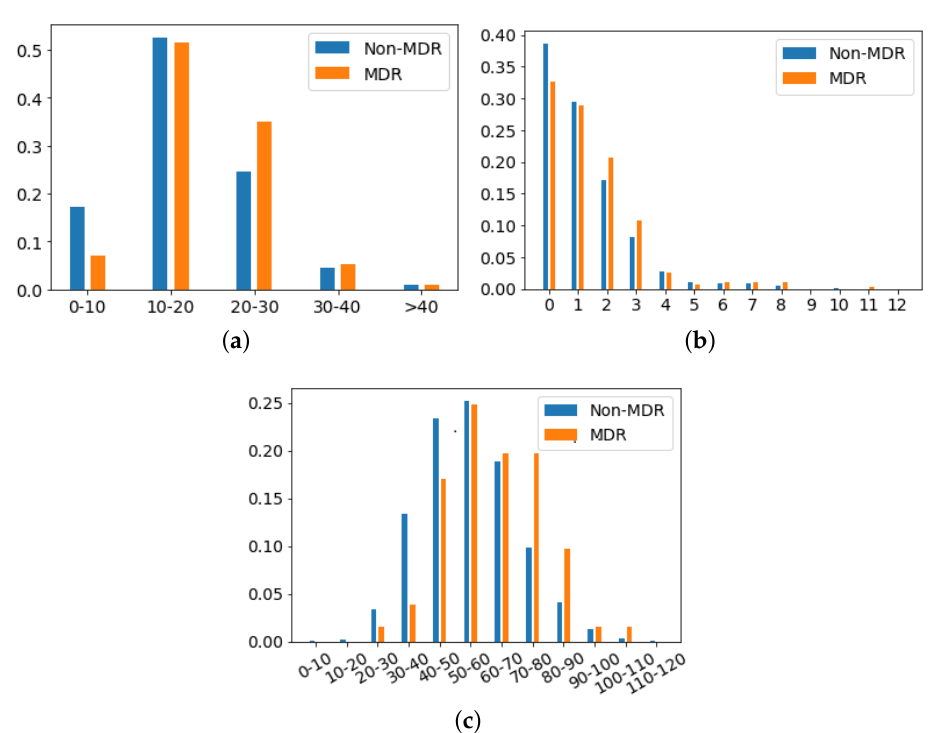
Figure 6. Rate of patient episodes for both MDR and non-MDR when three clinical scores are considered: ( a ) Apache II , ( b ) Charlson and ( c ) SAPS III .